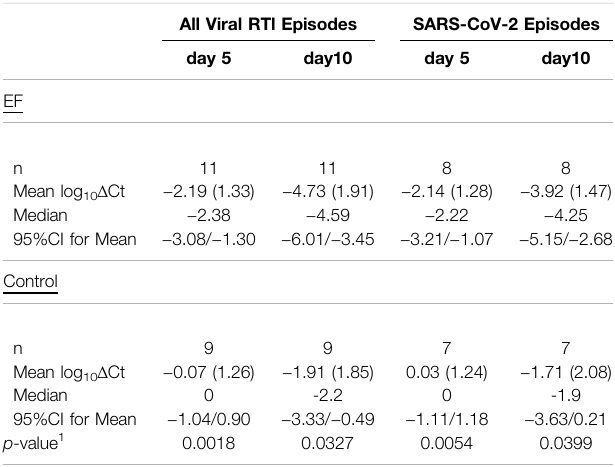
TABLE 3 | Log change in virus load during EF treated (Echinaforce) vs. untreated (control) symptomatic RTI episodes. All Viral RTl